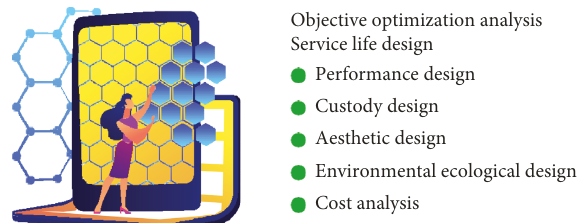
Figure 1: Schematic diagram of the whole life cycle design